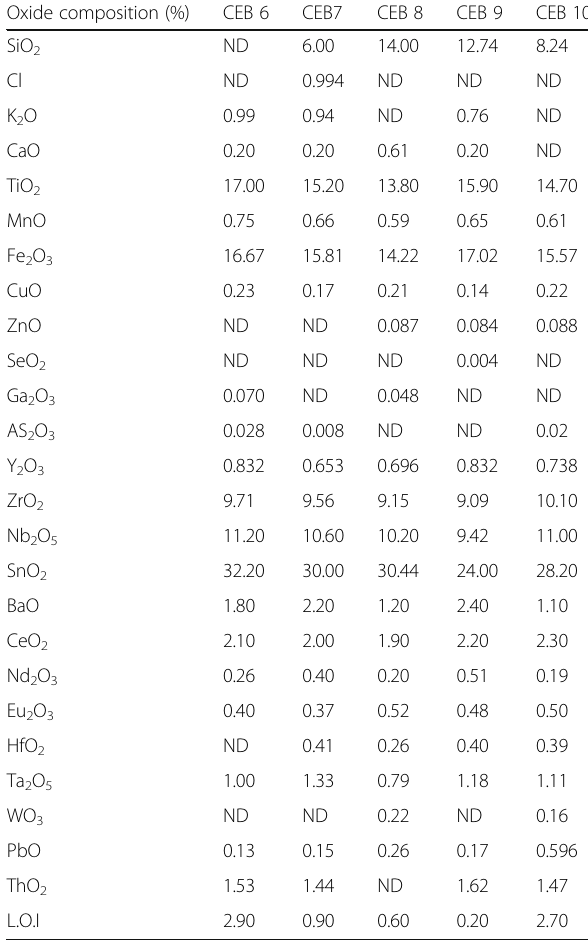
Table 3 Analyzed cassiterite samples at